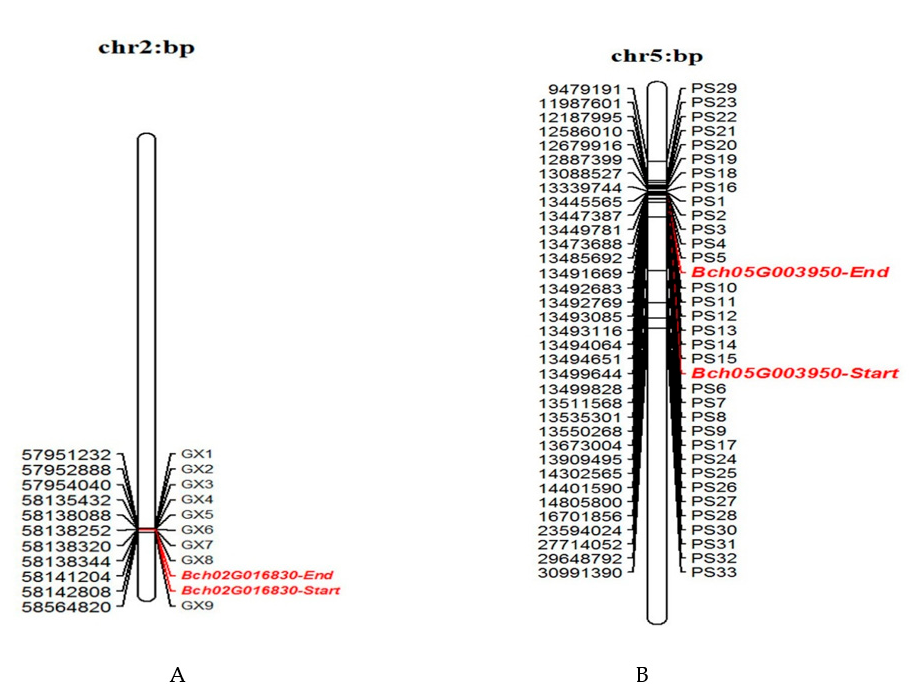
Figure 1. Physical maps of InDel markers linked to fruit-shape ( A ) and peel-colour genes ( B ). Numbers on the left side of the map indicate the physical distance (bp) of the gene and InDel markers. Numbers on the right side are genes and InDel markers.